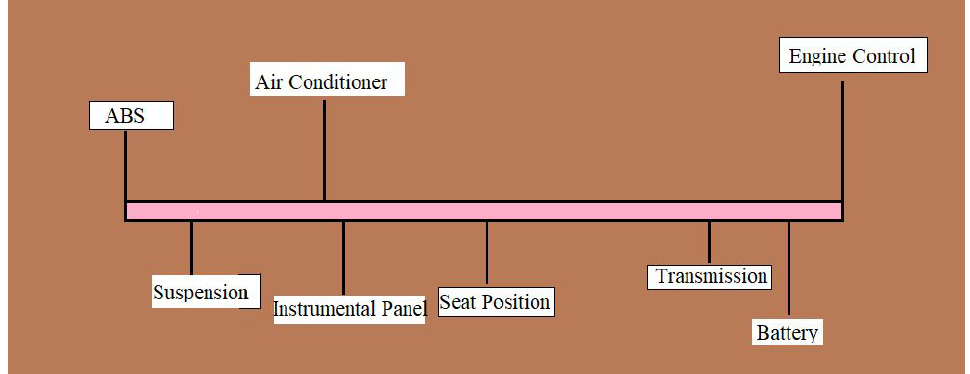
Figure 3. CAN used for ECM communication in